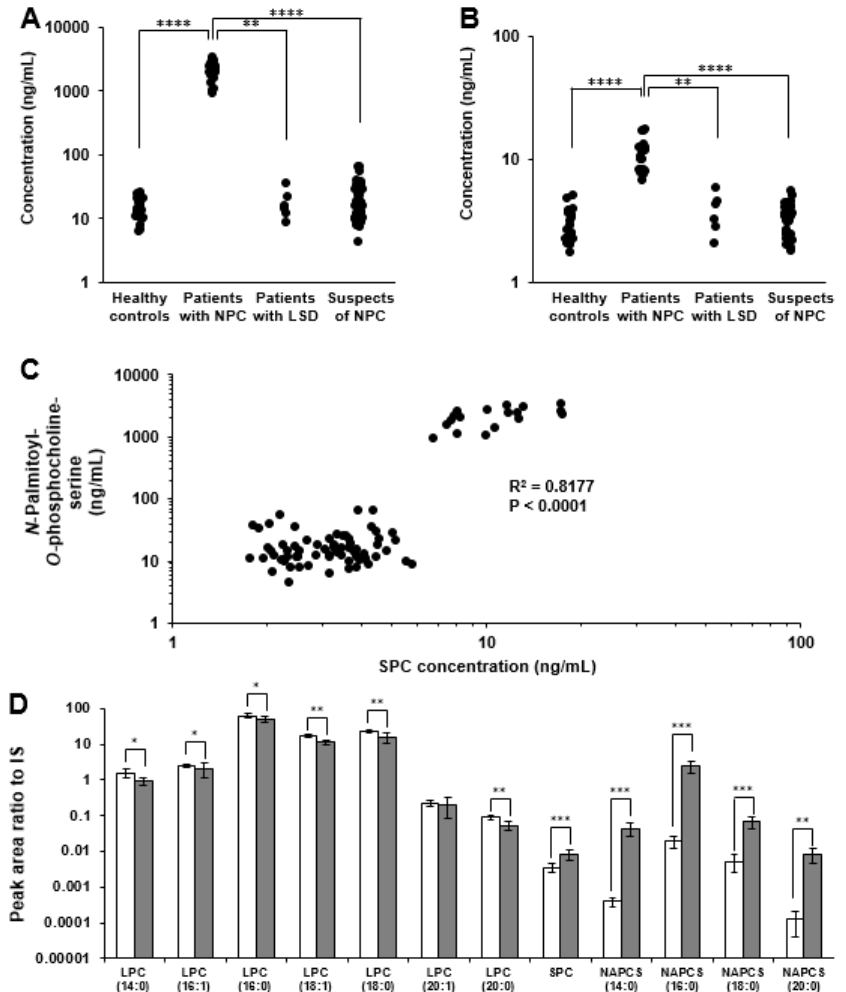
Figure 8. Analyses of various class lipids in serum / plasma. ( A ) The serum / plasma concentration of N -palmitoyl- O -phosphocholine-serine. ** p < 0.01, *** p < 0.0001, Steel–Dwass test. ( B ) The serum/plasma concentration of SPC. ** p < 0.0001; **** p < 0.0001, Steel–Dwass test. ( C ) Correlation of the concentration between SPC and N -palmitoyl- O phosphocholine-serine. ( D ) Targeted lipidomics for lipids having phosphocholine group. * p < 0.05; ** p < 0.01; ** p < 0.001; Wilcoxon’s test. LSD, lysosomal storage disorder.